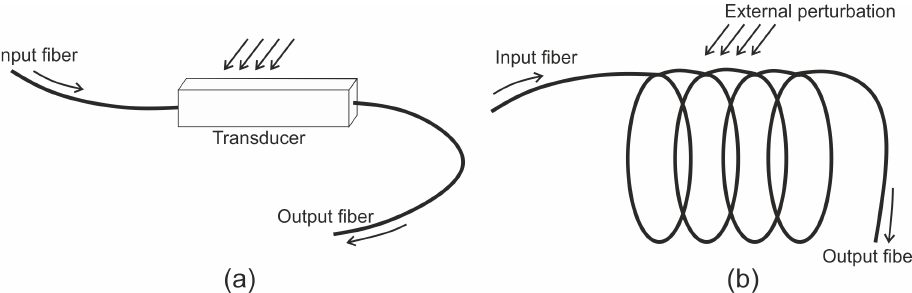
Figure 1. Fiber-optic sensor types: ( a ) extrinsic and ( b ) intrinsic (based on reference